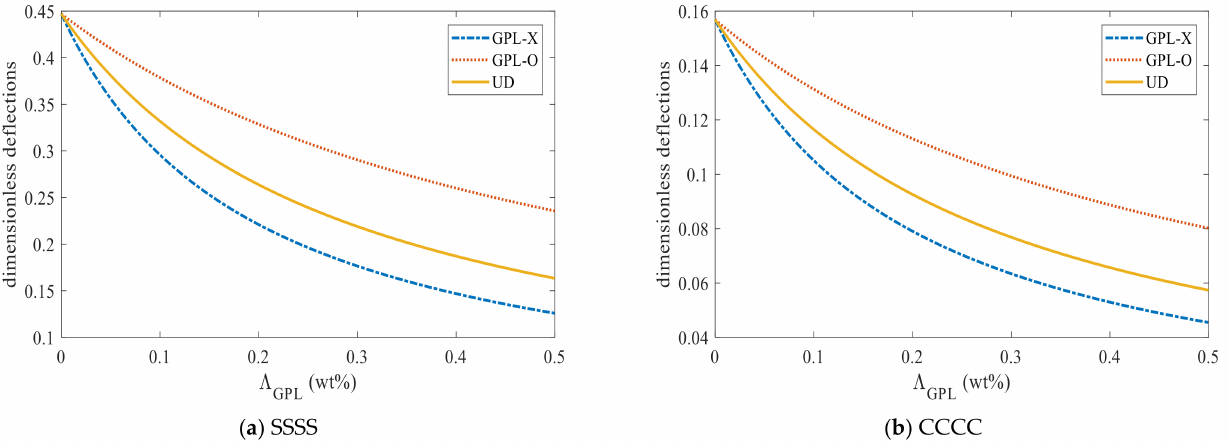
Figure 13. Dimensionless deflection changes vs. GPL weight fraction, for different distribution patterns of reinforcement ( b / a = 1, a / h = 10, p = 10 5 ) : ( a ) SSSS boundary conditions, ( b ) CCCC boundary conditions. 0